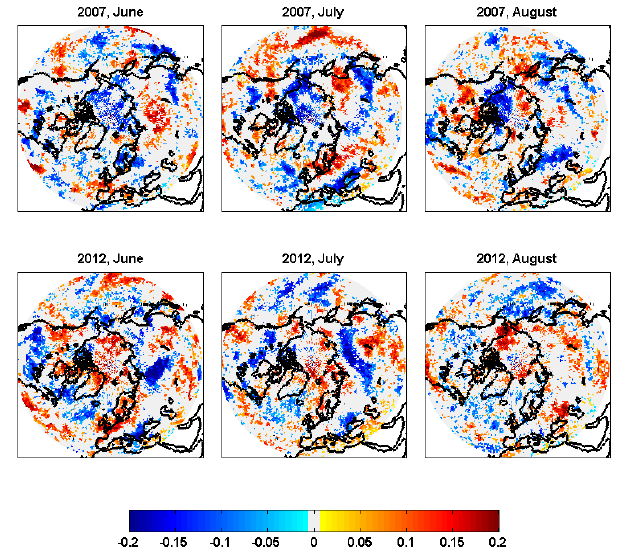
Fig. 11. Cloud fraction anomalies for the JJA months of 2007 (top Fig. 11: Cloud fraction anomalies for the JJA months of 2007 (top row) and 2012 (bottom row) and 2012 (bottom row).